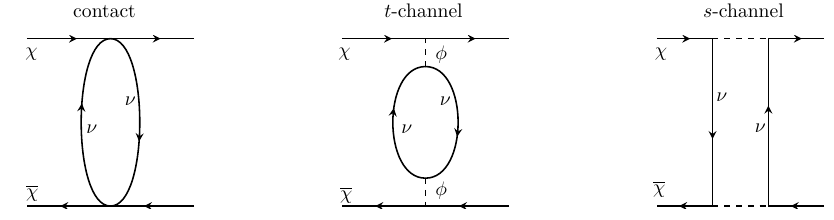
Figure 1 . Examples of the solutions of the radial Schrödinger equation for Yukawa potentials.